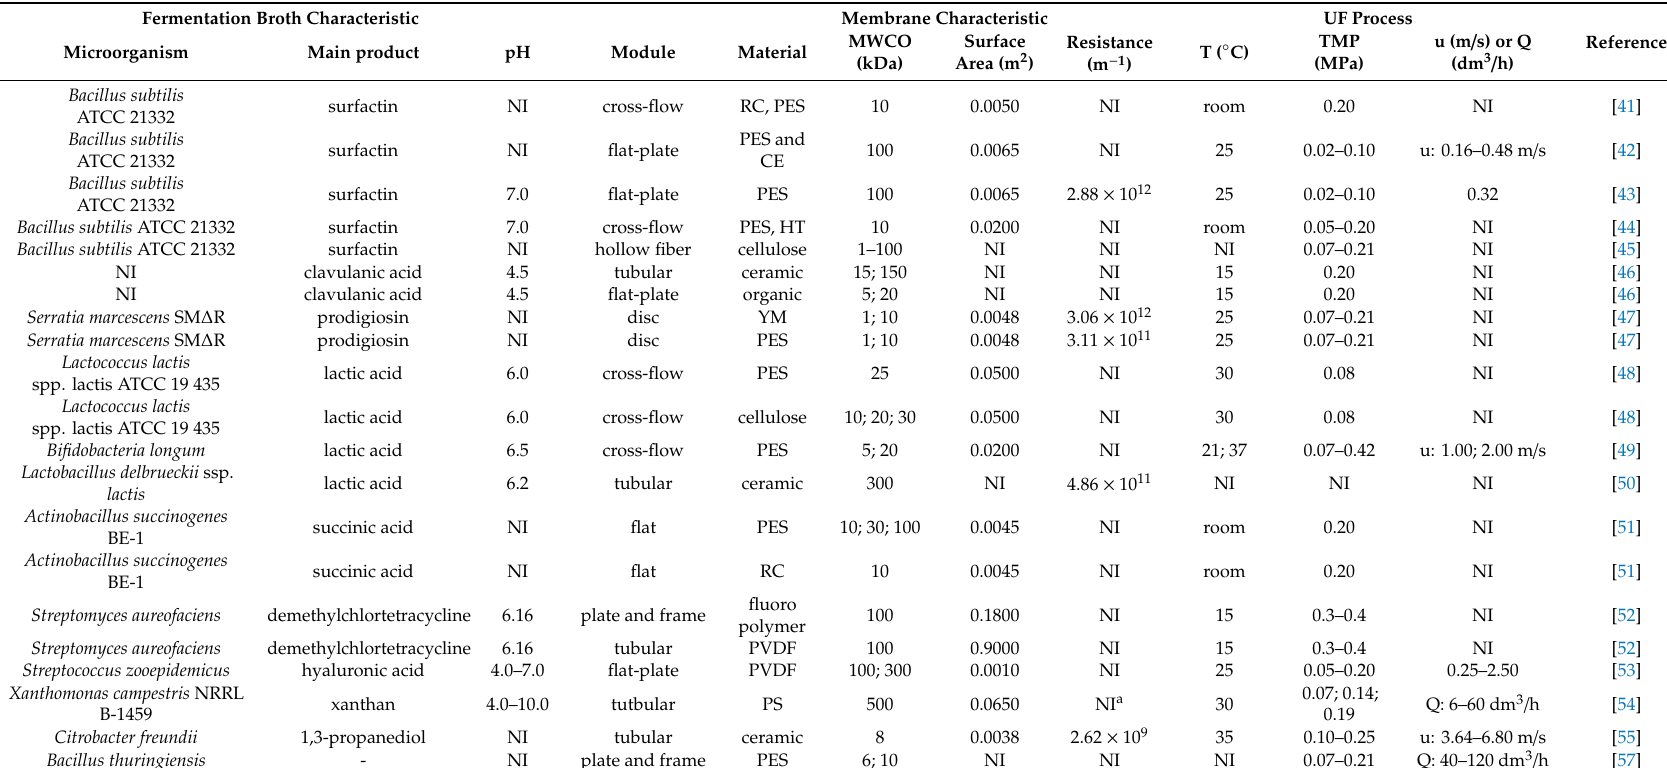
Table A1. Literature review on the UF process of fermentation broths: experimental